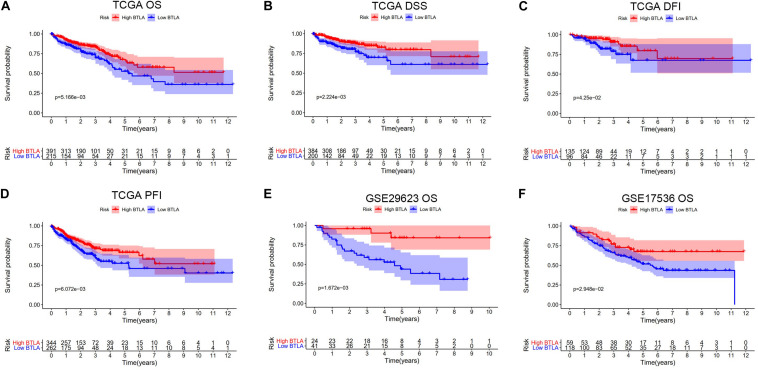
Kaplan-Meier survival curves comparing the different expression of BTLA groups in colorectal cancer in TCGA cohorts and GEO cohorts. (A–D) Survival curves of OS, DSS, DFI, PFI in TCGA colorectal cancer cohorts. (E,F) Low BTLA expression was correlated with poor OS in the GEO cohorts. OS, overall survival; DSS, disease-specific survival; DFI, disease-free interval; PFI, progression-free interval.